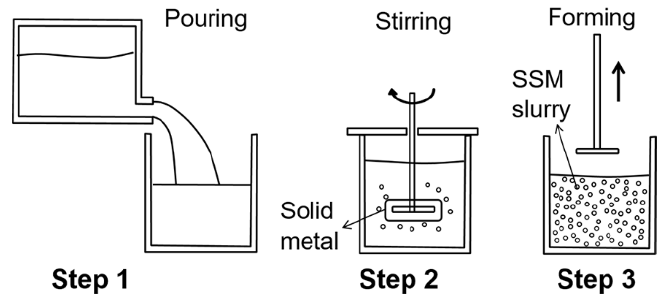
Figure 16. Schematic diagram of RSF process, consisting of pouring liquid metal into an insulated container (Step 1), then submerging a solid metal alloy, usually in the form of a bar of the same composition, into the melt (Step 2), and obtaining semi-solid slurry after the stirring operation (Step 3) [165].